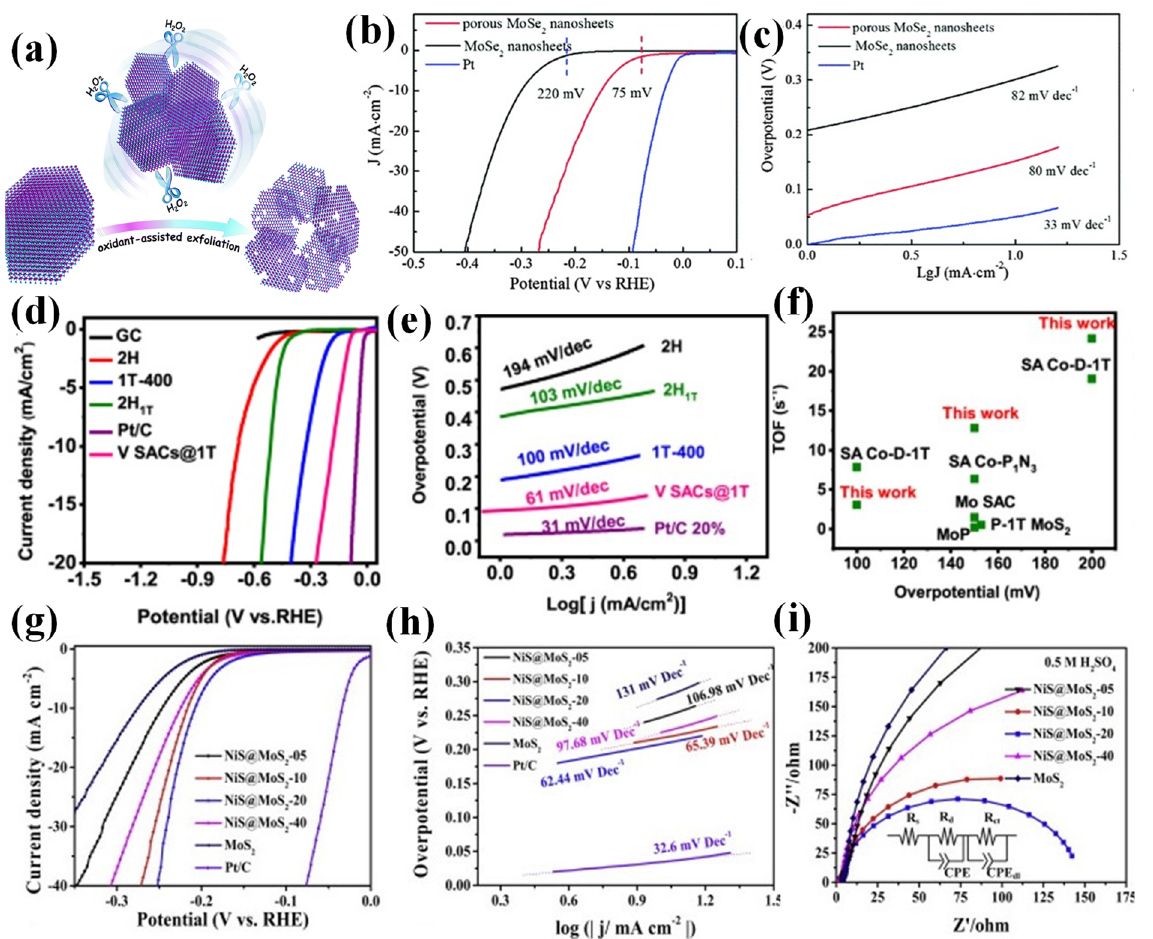
Figure 7. ( a ) Synthesis description for the fabrication of porous MoSe 2 nanosheets; ( b , c ) polarization curves and Tafel plots of porous MoSe 2 nanosheets, respectively [77]; comparison ( d ) LSV and ( e ) Tafel plots of GC, 2H, 1T-400, 2H 1T , Pt/C and V SACs@1T-WS 2 electrodes in 0.5 M H 2 SO 4 with a scan rate of 5 mV s −1 ; ( f ) TOF comparison with other representative electrocatalysts [47]; ( g ) polarization curves, ( h ) Tafel slopes, and ( i ) Nyquist plots of MoS 2 , NiS@MoS 2 -05, NiS@MoS 2 -10, NiS@MoS 2 -20, NiS@MoS 2 -40 and 20 wt% Pt/C in 0.5 M H 2 SO 4 solution [78].